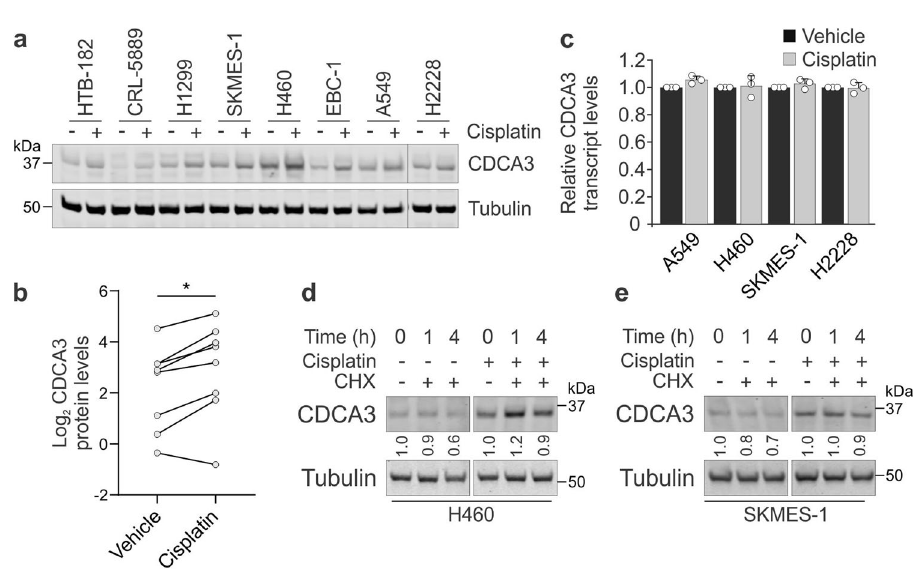
Fig. 2 Platinum agents induce an upregulation of CDCA3 protein. a Representative endogenous CDCA3 western blot analysis from lysates of NSCLC cell lines treated in the absence or presence of cisplatin. Tubulin used as loading control. b Densitometry quanti fi cation of a , with dot points representing average log2 of relative CDCA3 levels from three independent experiments with lines connecting respective untreated and cisplatin treated cell lines (paired Student ’ s t test, * P = 0.0174). c Graphical representation of CDCA3 transcripts from NSCLC cell lines treated with or without cisplatin determined using qRT-PCR. Comparative CT values normalised to housekeeping transcript 7SL and relative to untreated controls for each cell line. Mean ± SD from n = 3 in triplicate. d , e Endogenous CDCA3 western blot analysis of H460 ( d ) and SKMES-1 ( e ) lysates assessing protein turnover by treating with cycloheximide over 4 h in the presence or absence of cisplatin. Tubulin used as a loading control. Densitometry quanti fi cation of CDCA3 levels relative to 0 h indicated below CDCA3